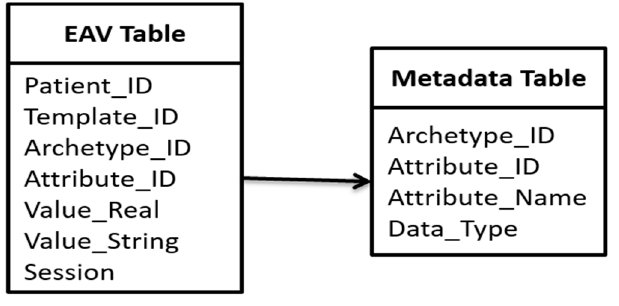
Figure A2. EAV storage schema for experimentation.